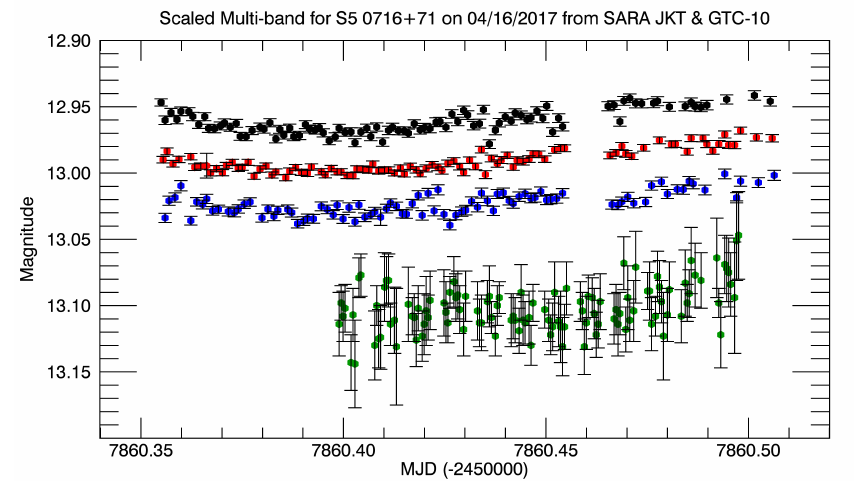
Figure 9. The composite light curve for all CIRCE-SARA data taken on 16 April 2017. All bands other than R were offset to fit easily